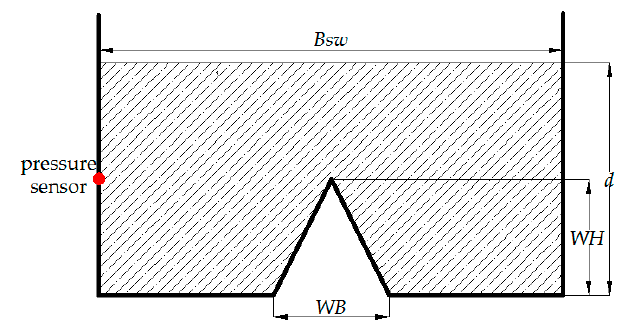
Figure 5. Configuration of the water tank.